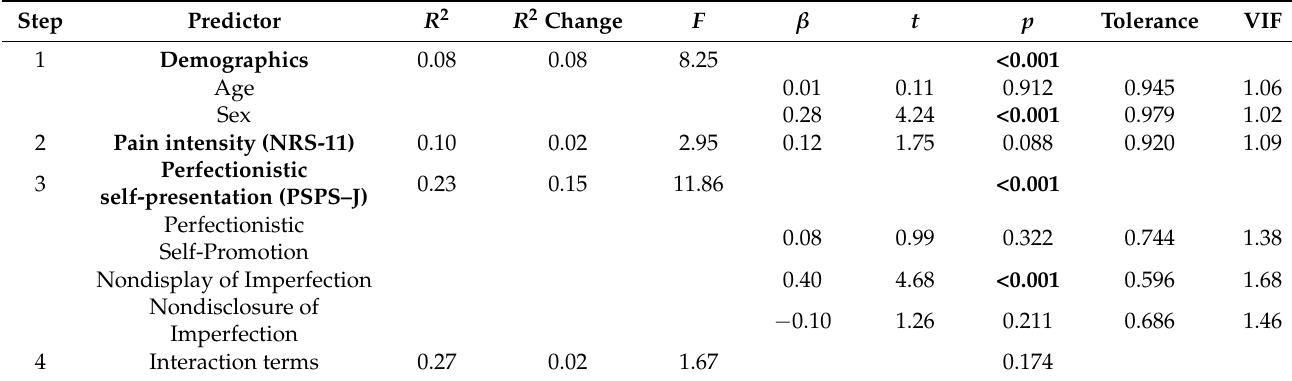
Table 5. Regression analysis explaining pain catastrophizing (PCS-C).